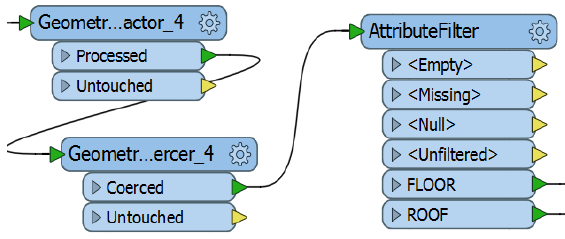
Figure 8: Geometry refinement of IFC Slab